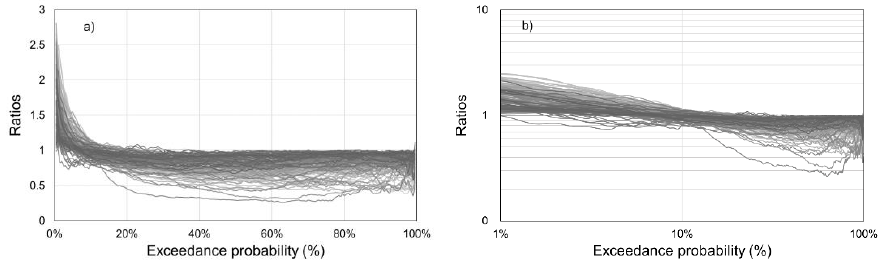
Figure 5. Ratios of daily to monthly FDCs at given exceedance probabilities; ( a ) conventional coordinates; ( b ) double logarithmic